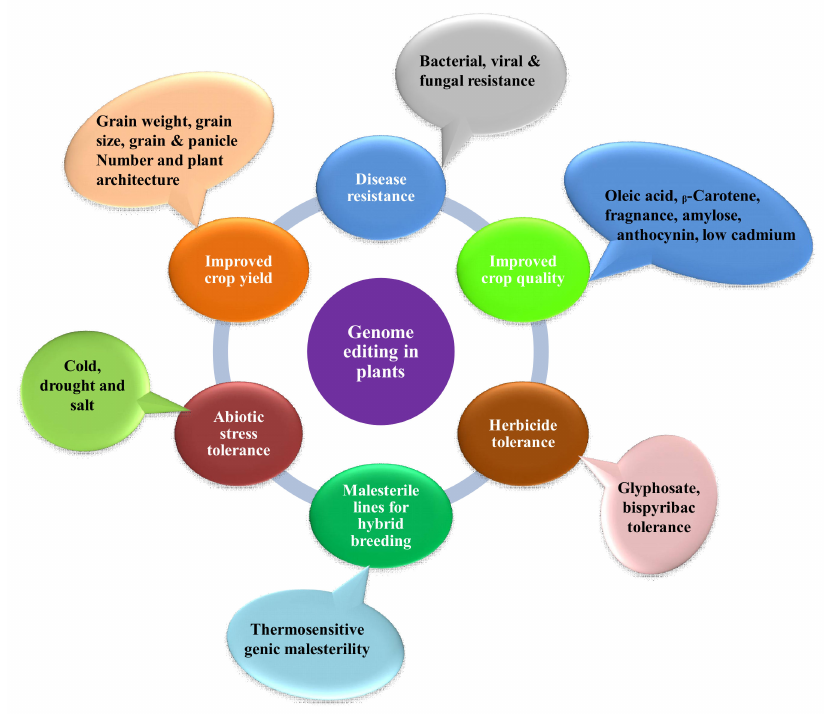
Figure 1. Applications of genome editing in crop plants for improving various traits.